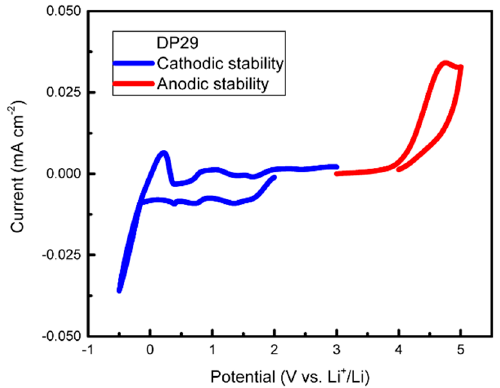
Figure 6. Cyclic voltammetry of SPE-3 DP29. Data showing plating and stripping of Li at 0 V and stability up to 4 V. The peaks between 0.5 and 2 V indicate a slight cathodic instability. CV cycling was performed at a scan rate of 0.2 mV s − 1 , 70 °C, r = 0.08, in a Li/SPE/stainless steel cell (anodic scan), and in a Li/SPE/Cu cell (cathodic scan).